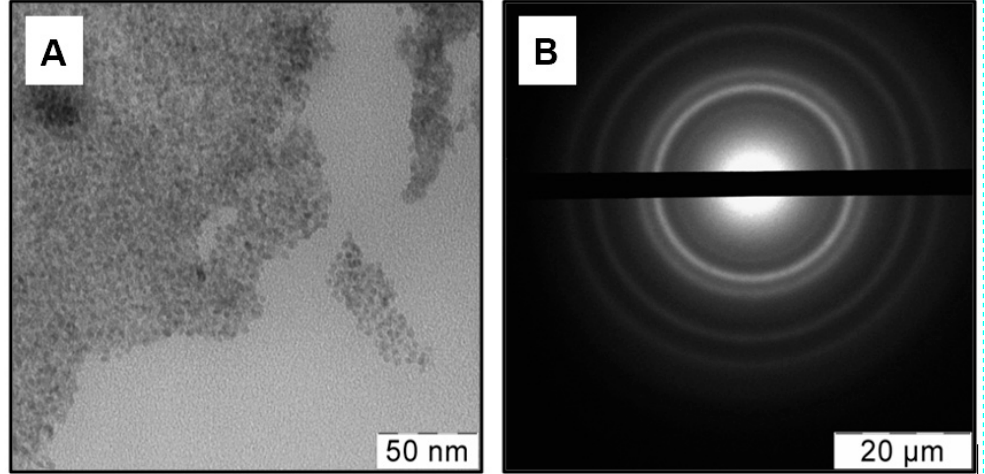
Figure 2. TEM image in bright field ( A ) and selected area diffraction pattern (SAED) ( B ) from a region for Cu-acetone organosol.